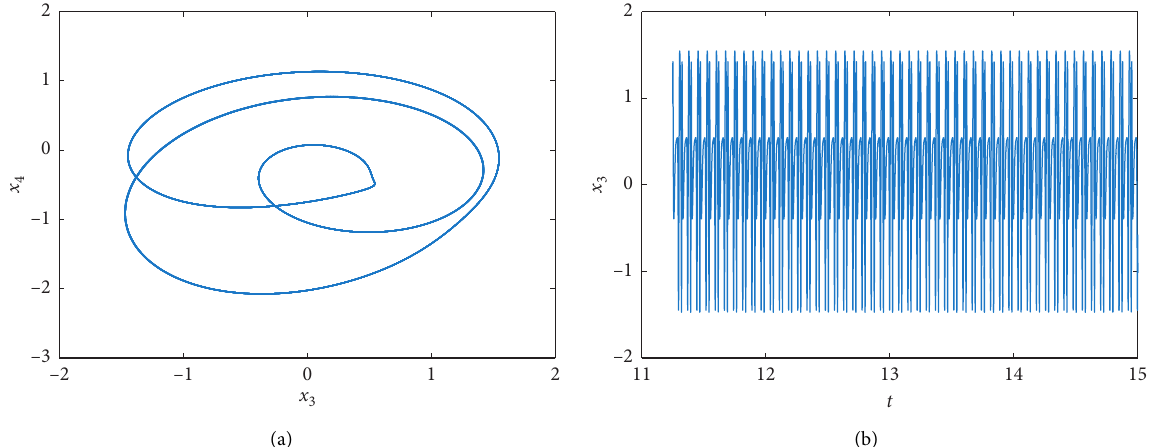
Figure 13: Phase portrait on plane ( x motion when P